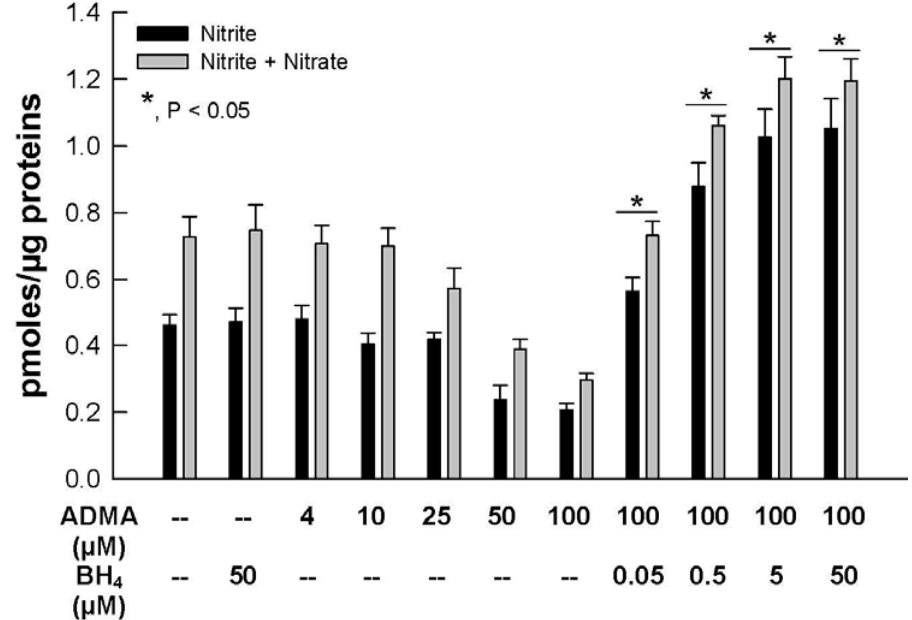
Figure 4. Effects of BH ADMA. HUVEC NO were exposed for 2 hrs in 0–100 µM ADMA alone or 100